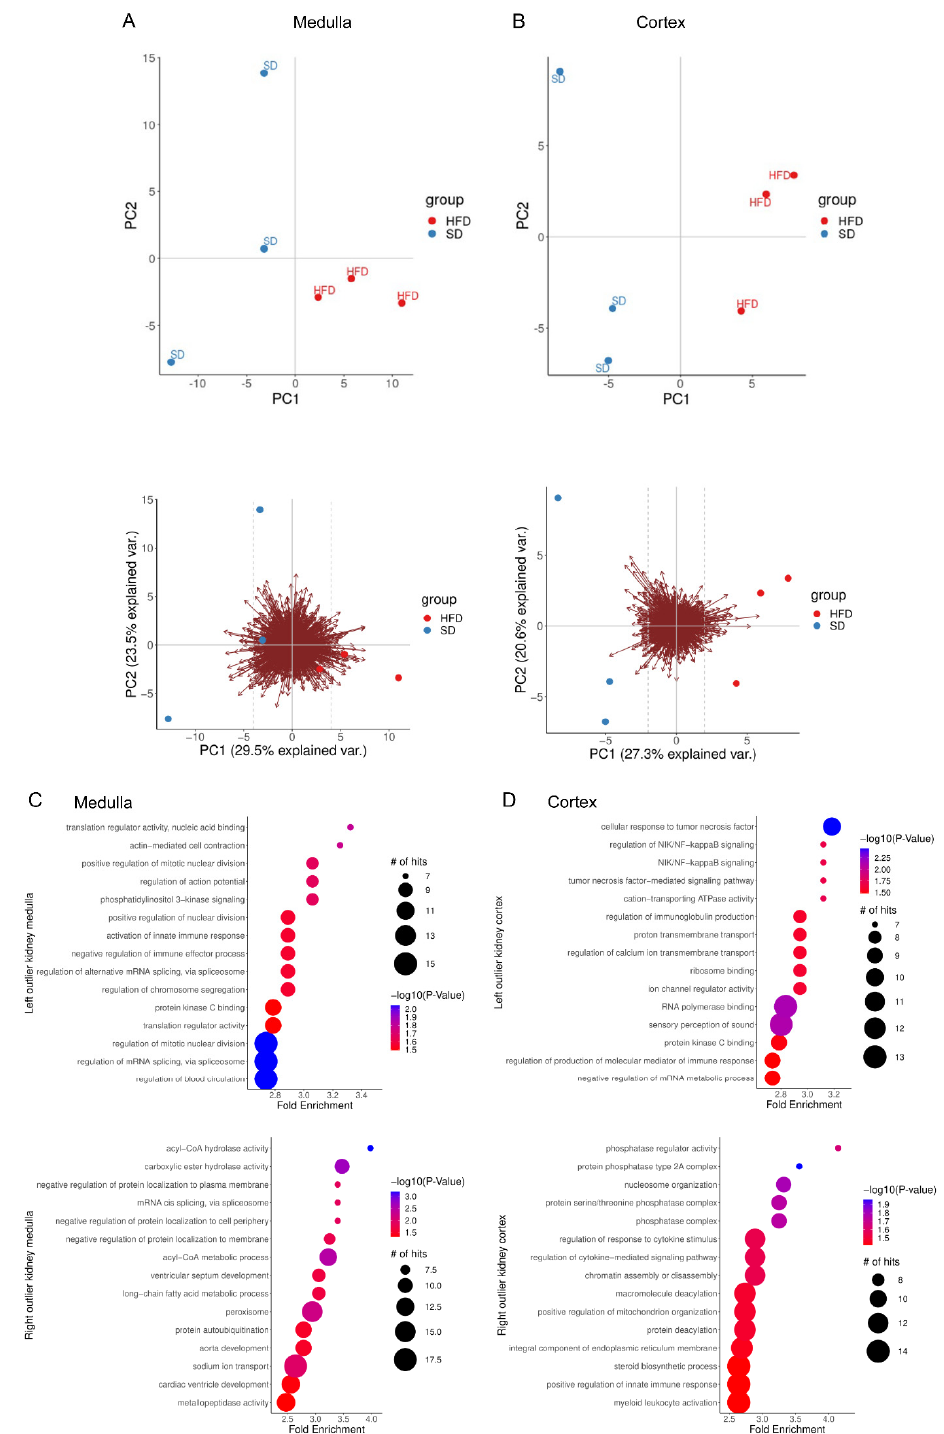
Figure 2. Comparison of kidney’s transcriptome from male offspring with maternal high-fat diet (HFD) or standard diet (SD). Cortex and medulla were studied separately. ( A , B ): Medulla and cortex, respectively: PCA of all genes. The lower plots show the biplots: the PCA scores together with the loadings (arrows) of all genes. The dashed lines indicate the cutoffs used to define left and right outliers. ( C , D ): Medulla and cortex, respectively: Bubble plots of top 15 enriched GO-terms of left and right outliers shown in upper and lower plot, respectively. p value depicted as color code, number of annotated genes corresponding to bubble